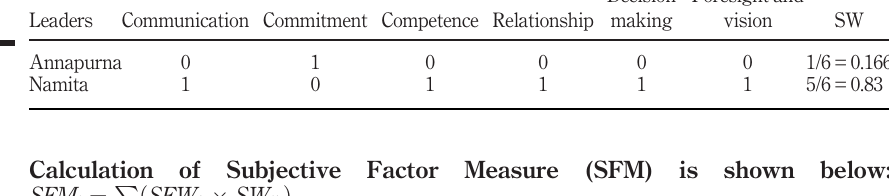
Table 10 Objective Factor Cost calculation of both leaders.